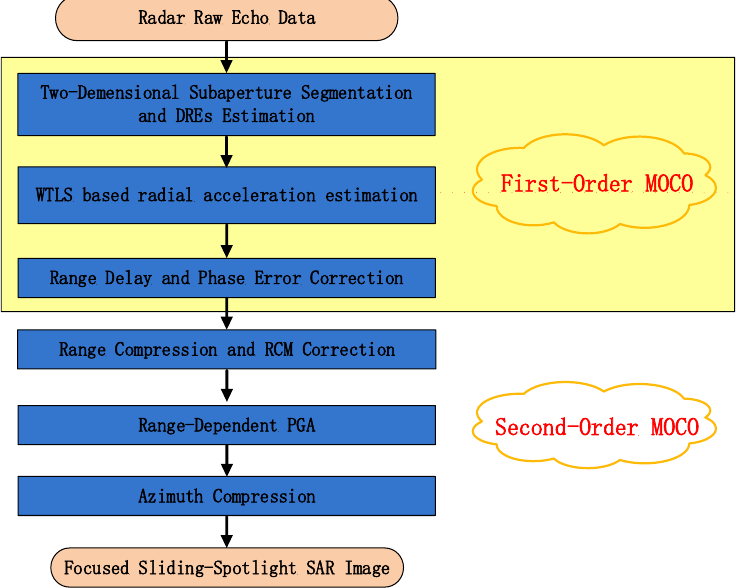
Figure 2. Main flowchart of proposed approach for sliding spotlight Synthetic Aperture Radar (SAR) image formation.